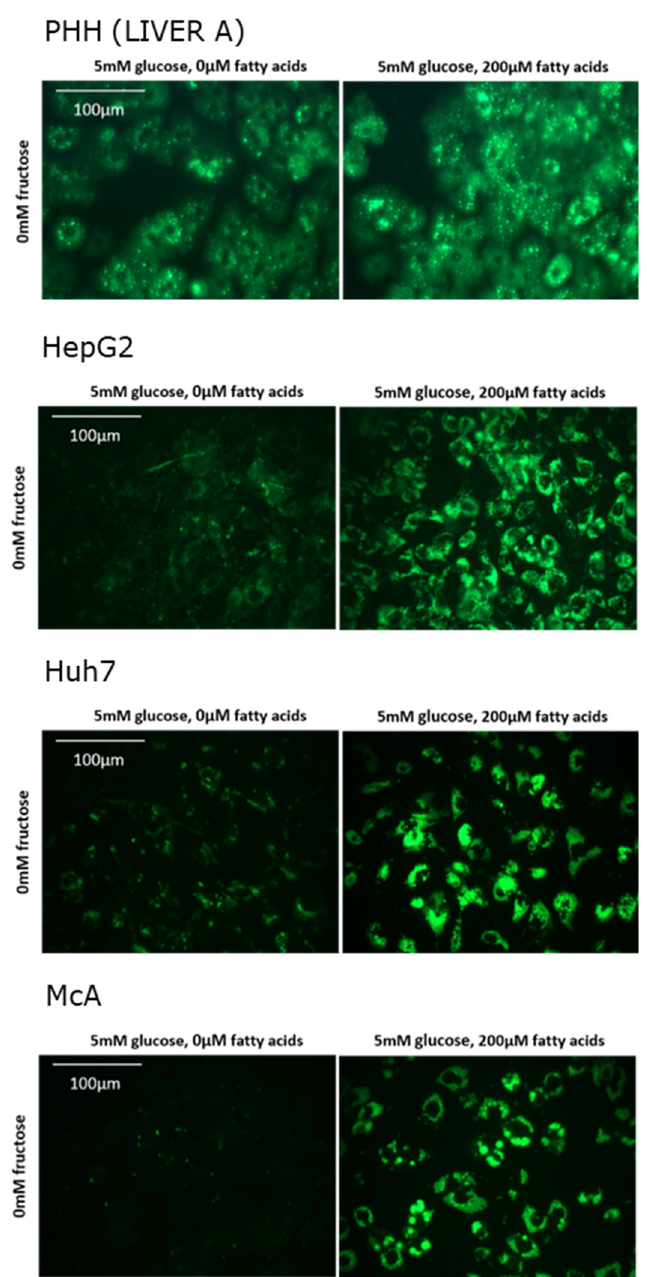
Figure 1. Effect of fatty acids on lipid accumulation in in different cell types. Lipid was visualised by staining with Nile Red and viewed under green fluorescence.